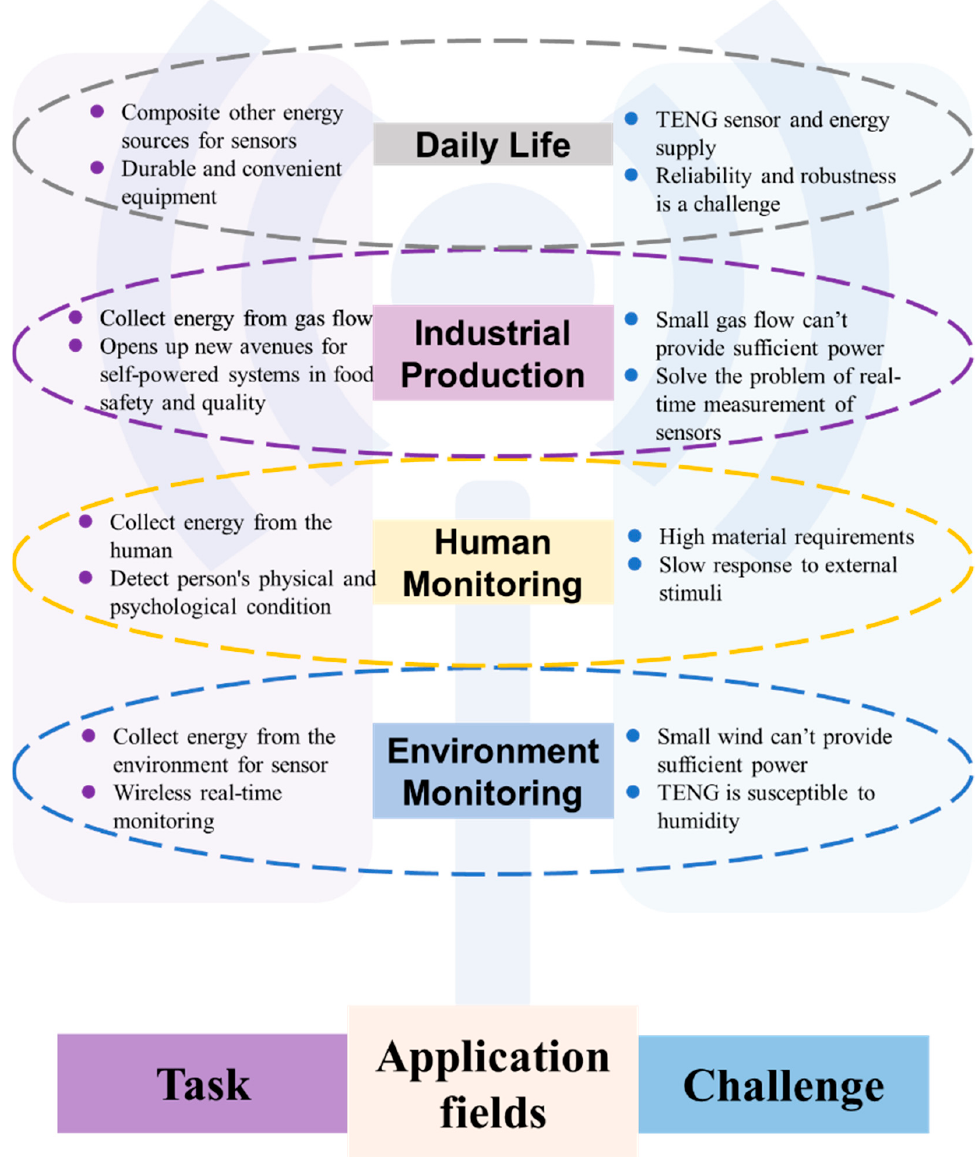
Figure 10. Summary and perspectives of self-powered wireless sensors based on TENG applications in environment monitoring, human monitoring, industrial production, and daily life.